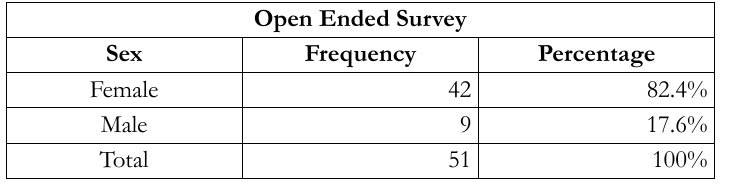
Table 5. Open ended survey information